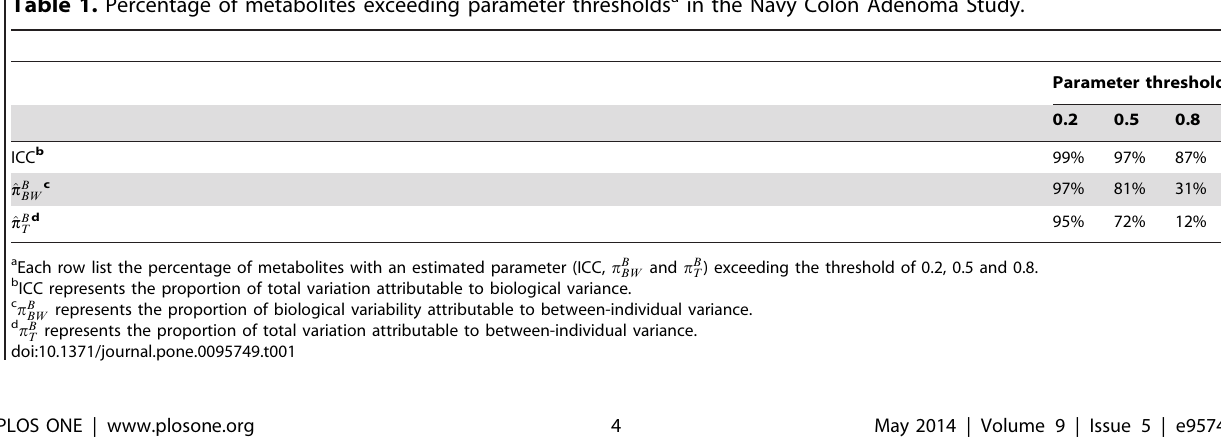
Figure 1. The plots illustrate the distribution of technical ICCs (A) and ^ pp B Adenoma Study. The ICC is a measure of laboratory variability. The ^ pp B for the specified metabolite quantile ranking. Median ICC: 0.92. Median ^ pp B and ^ pp B T